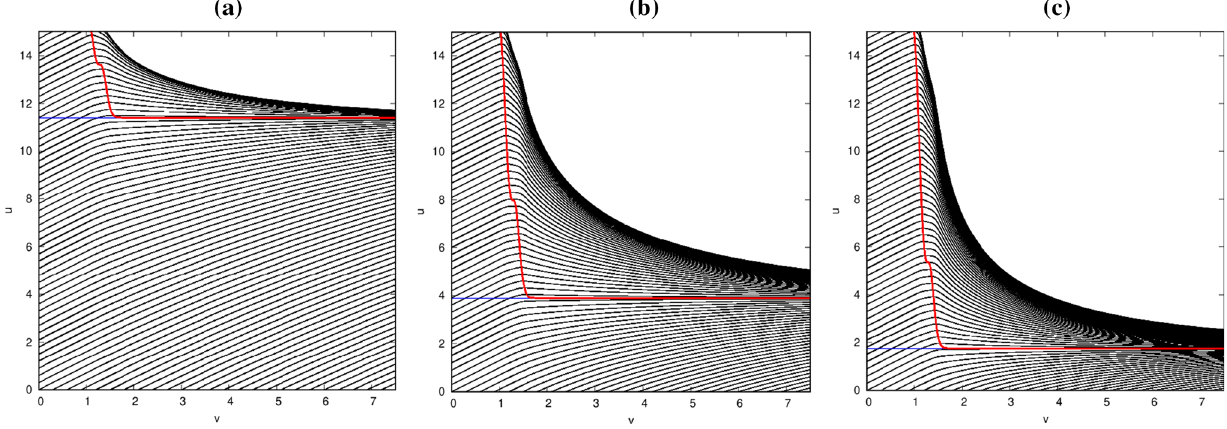
−√ 3 and γ = − 0 . 01. The field amplitudes ˜ p s = ˜ p h were equal to